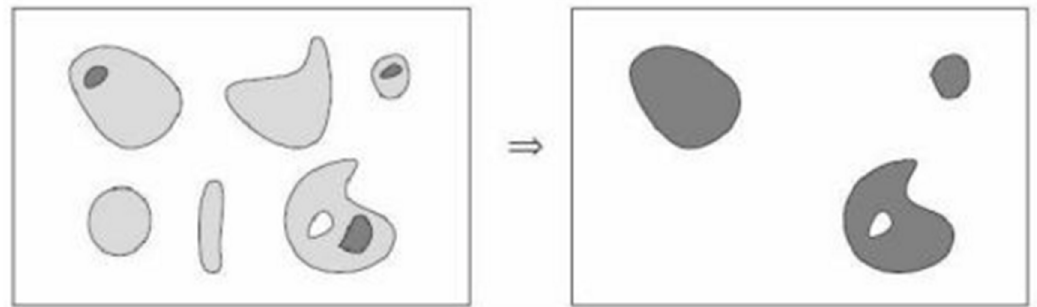
Figure 1. Morphological reconstruction.